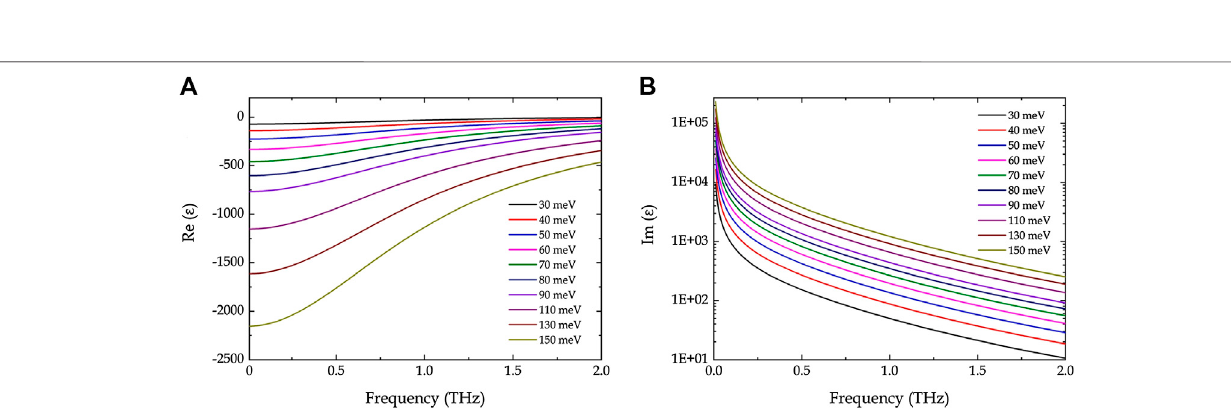
Frontiers in Physics |